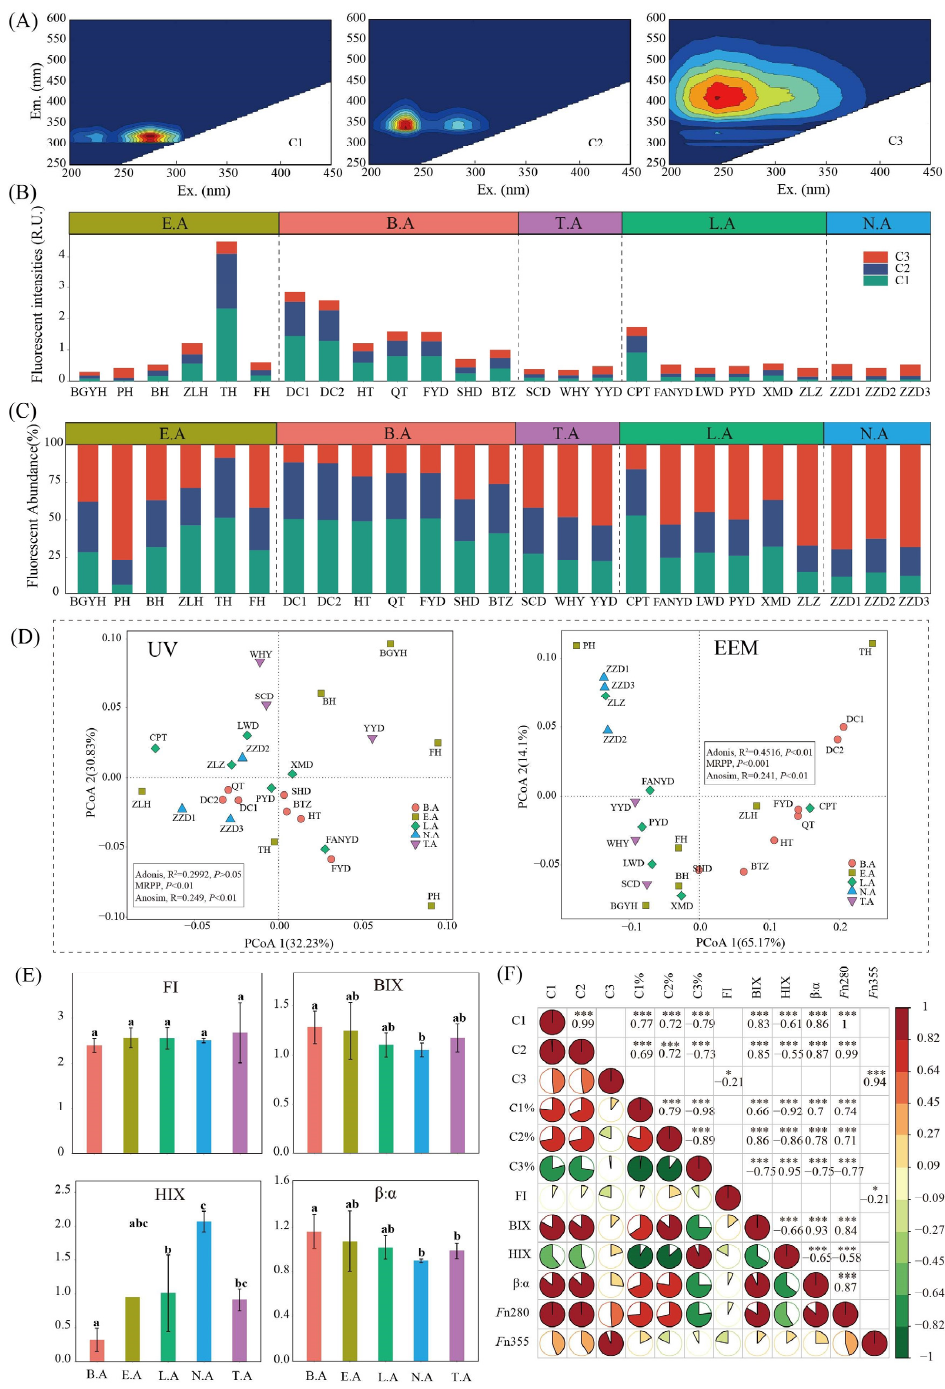
Figure 6. Fluorescence components and spatial distributions of fluorescence intensities and relative abundance in Baiyangdian Lake. ( A ) Fluorescence components; ( B ) Fluorescence intensities of fluorescence components; ( C ), Relative abundance of fluorescence components; ( D ) PCoA of CDOM based on UV and EEM; ( E ) Fluorescence indices; ( F ) correlation analysis (*, *** indicate the significance of the correlation at p < 0.05, and p < 0.001).